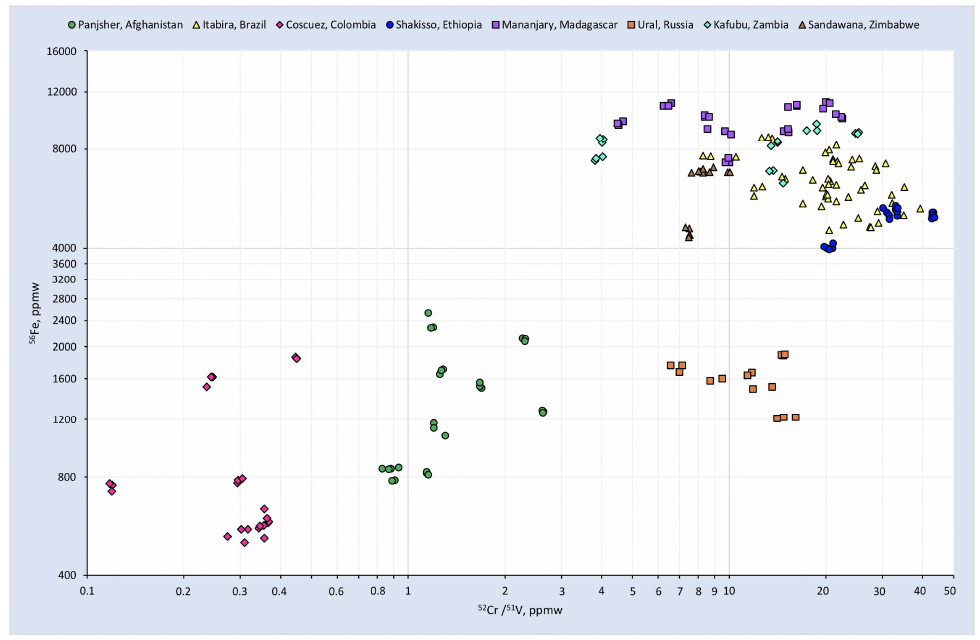
Figure 2. Binary plot of 52 Cr / 51 V vs. 56